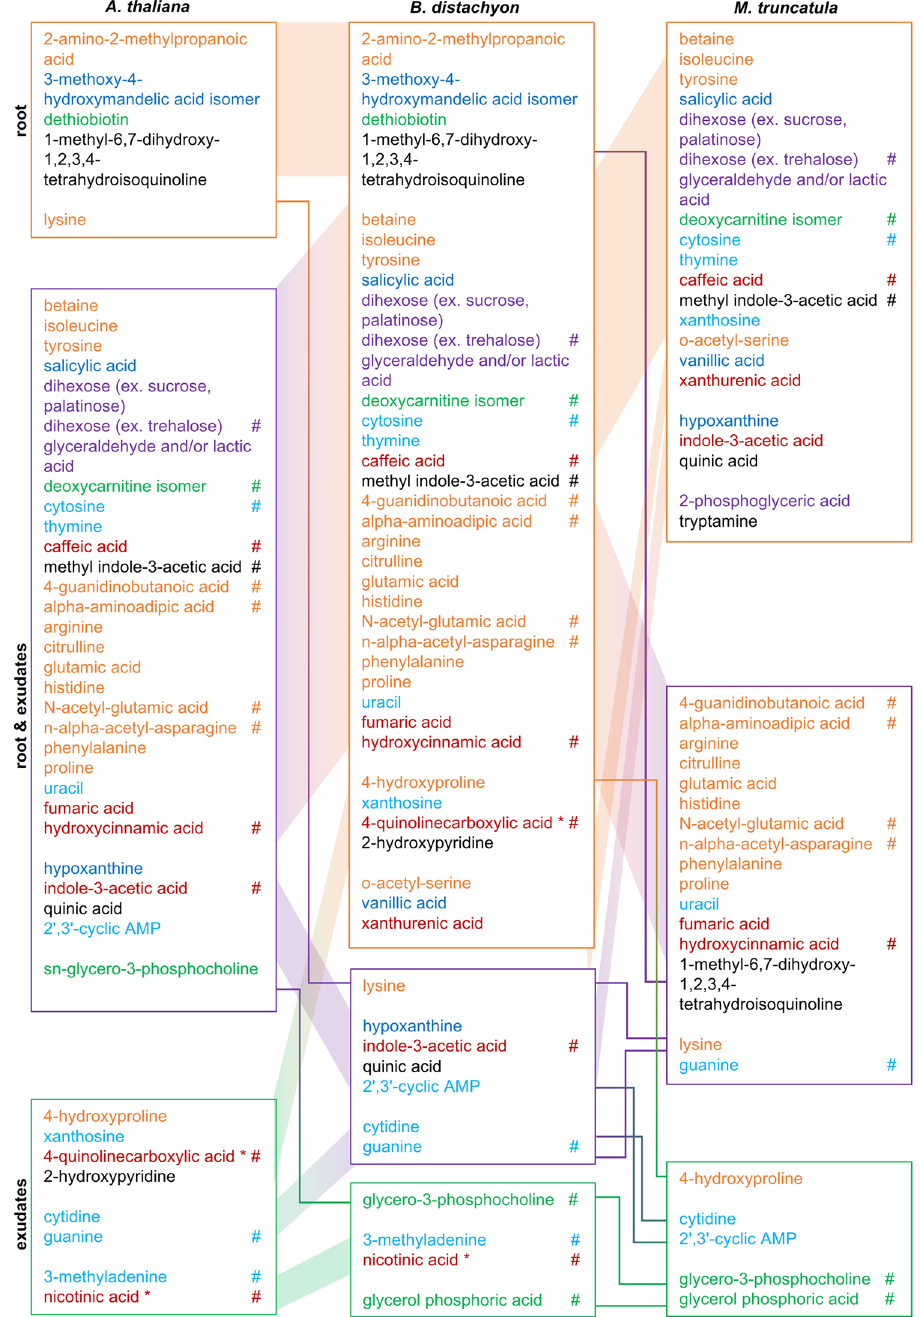
Fig.7|Speci fi cmetabolitesinrootsandexudates. Metabolitesdetectedinroots and/orexudates of one orseveralspecies. A speci fi cmetabolite is present in roots (orange box), roots and exudates (purple box), or exudates (green box). Its pre- sence in A. thaliana, B. distachyon , M. truncatula is indicated by the connecting colored lines. Number of jars with 3 – 5 plants: 3 – 8 for each timepoint. One repre- sentative experiment out of three total is displayed. Metabolites are colored by